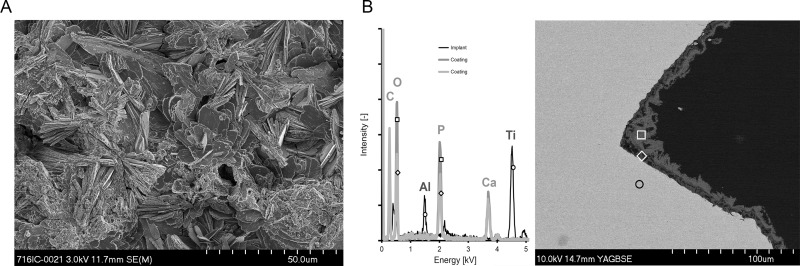
SEM analysis of surface morphology and coating thickness of the CaP coating used in the study.A.) Representative image of the CaP coating present on the TAN discs used during the in vitro aspect of the study. Scale bar is 50 μm. The image is from one disc and is representative of 2 further discs independently prepared and analyzed. B.) Left: Elemental composition of the CaP coating, as determined by energy dispersive X-ray analysis (EDX). The black line indicates the TAN screw, while the lower and upper layers of the coating are indicated by the light grey and dark grey lines, respectively. Right: Representative image of a longitudinal cross-section of the CaP-coated TAN screw (light grey) demonstrating the thickness of the CaP coating present on the screw and the regions of interest selected for the EDX analysis: screw–open black circle; lower level of CaP coating—open white diamond; upper layer of coating—open white square. Image is from one screw and is representative of 1 further screw, independently prepared and analyzed. Scale bar is 100 μm.